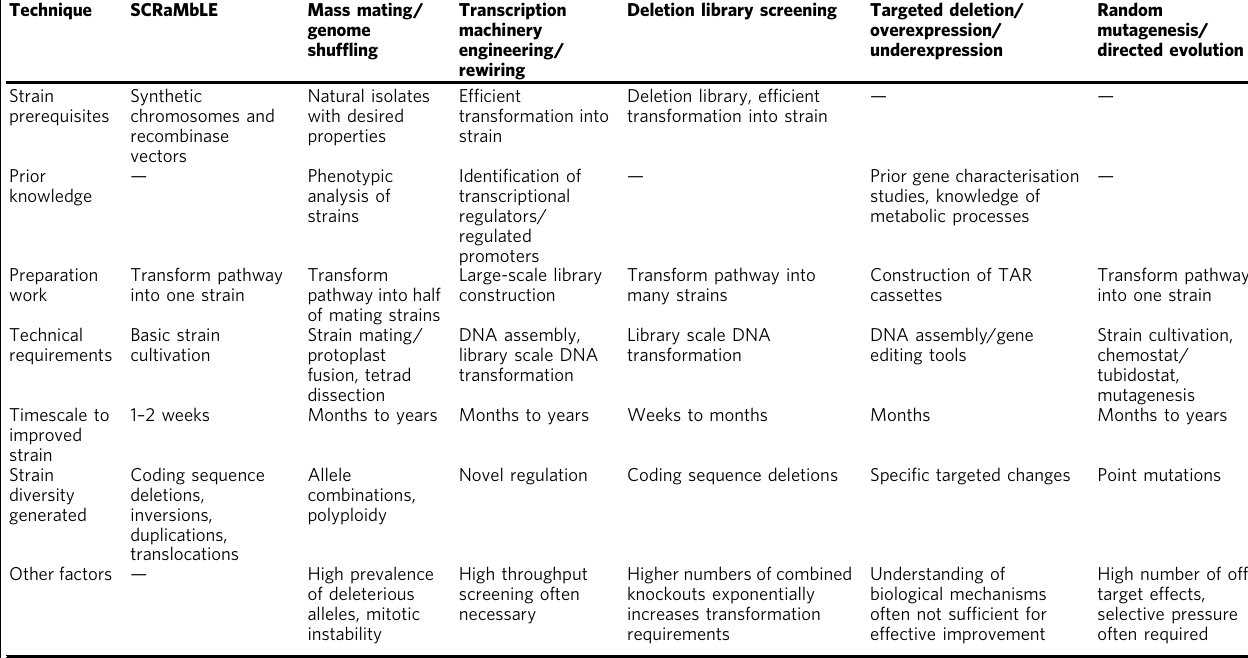
Table 1 Comparison of SCRaMbLE to common S . cerevisisae strain improvement